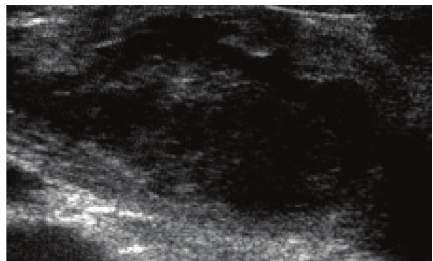
Figure 1: USG imaging of enlarged ovarian vein and thrombus in lumen.